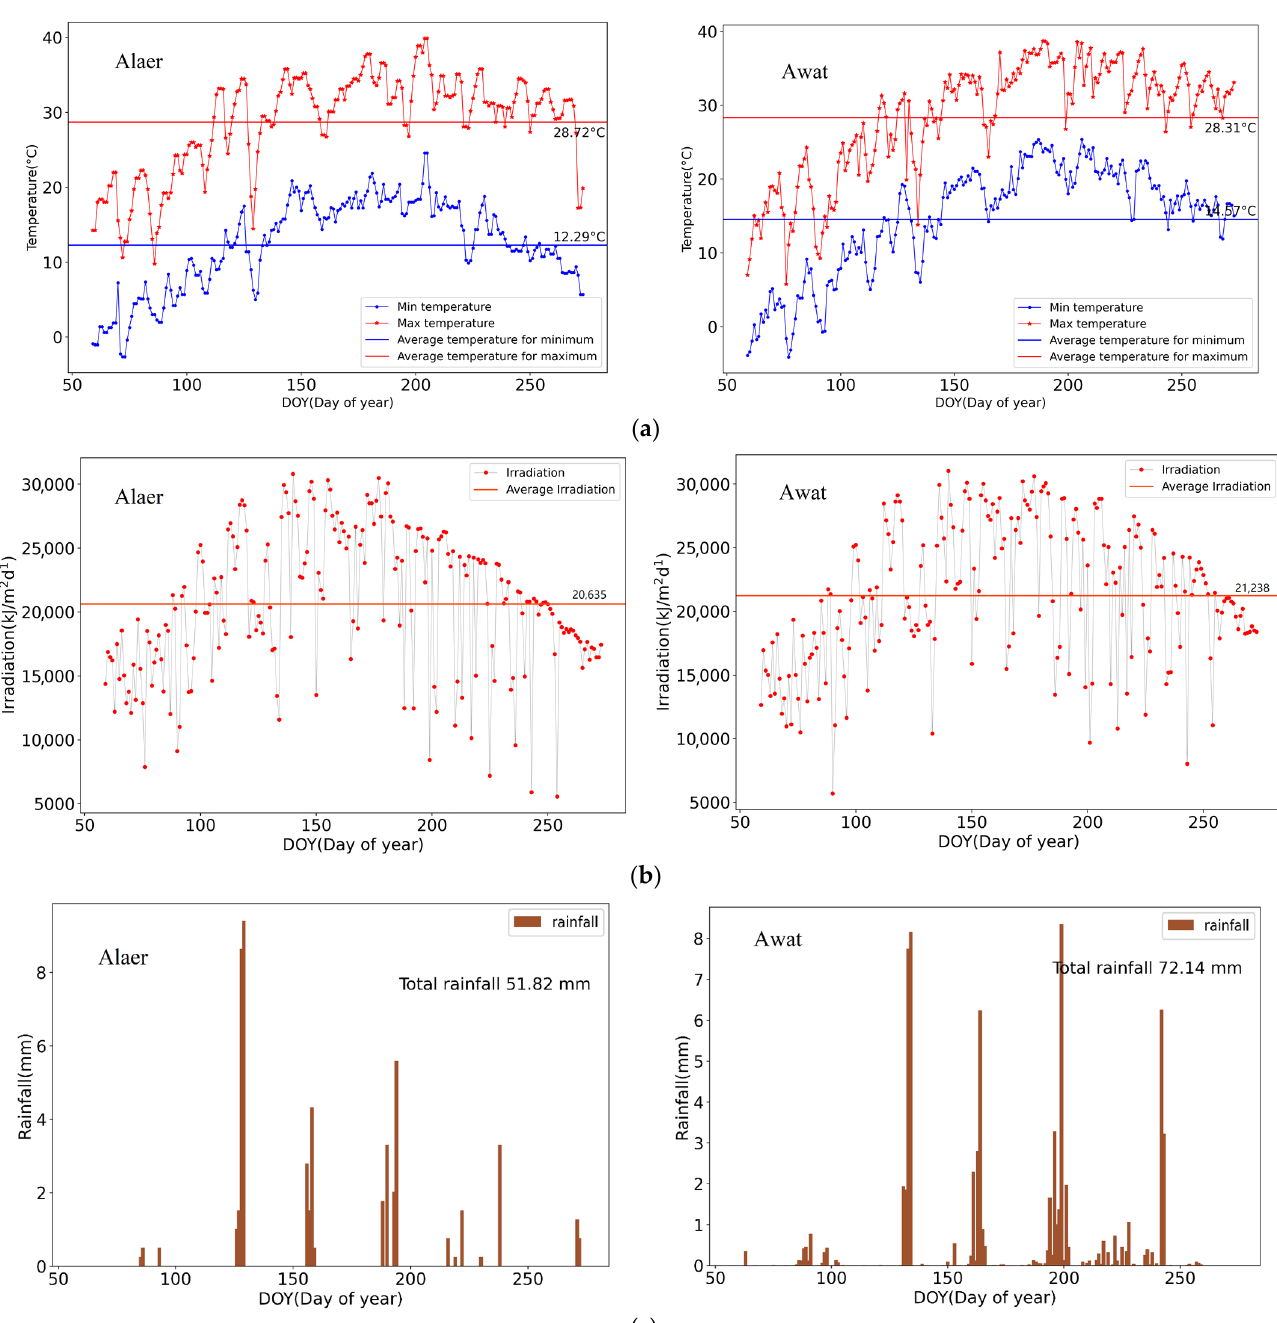
Figure 5. ( a ) Daily minimum and maximum temperature from March to October in Alaer and Awat; ( b ) daily total irradiation from March to October. (DOY: day of year); ( c ) daily total rainfall from March to October.